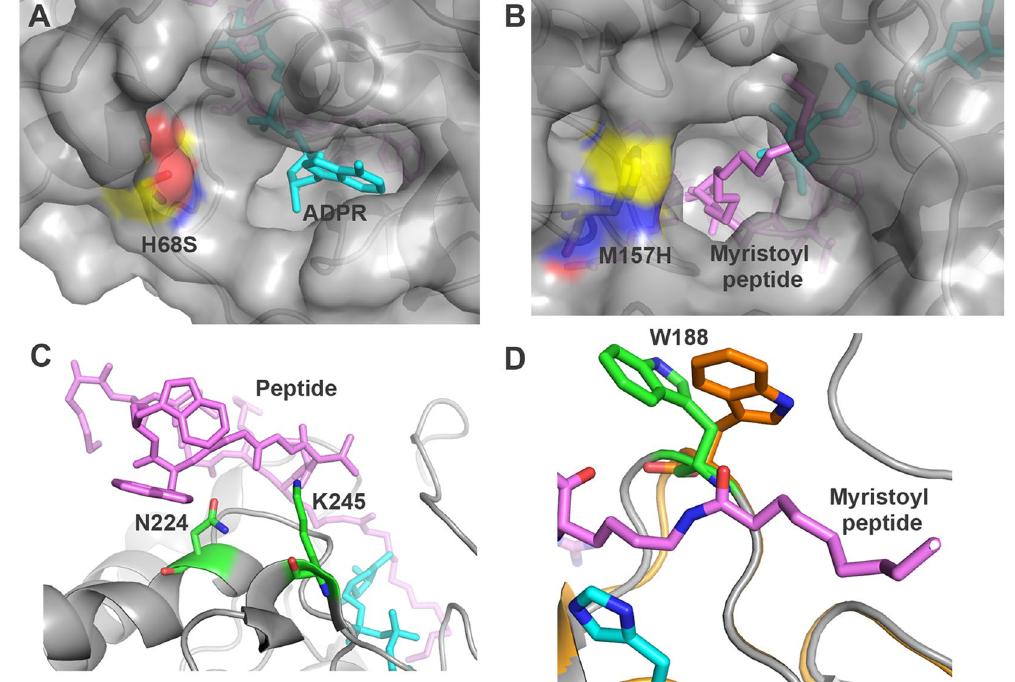
Figure 2. Structural analysis of residues that are mutated in the improved D1 and 6A4 SIRT6 variants. ( A ) Surface view of H68 region located in the vicinity of the NAD + binding pocket. ( B ) Surface view of M157 region located in the vicinity of the myristoyl moiety of the H3K9myr peptide. The H68S and M157H mutations found in D1 and 6A4 variants were generated in silico. Both mutations can contribute to improved k cat by better positioning of the peptide and NAD + for catalysis. ( C ) Residues K245 and N224 are located in the vicinity of the peptide backbone and can contribute to the low K M for the myrisoylated peptide. The K245P and N224S can eliminate interactions with the peptide in 6A4 leading to an increase in K M for the TNF- α peptide. ( D ) Residue W188 undergoes a significant conformational change upon peptide binding. The movement of W188 was identified by superposition of SIRT6 structure with myristoylated peptide (PDB 3ZG6) and without a peptide (PDB 3K35). The W188F mutation found in D1 can lead to better positioning of the peptide with respect to the catalytic H133